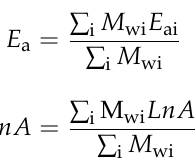
Table 3. Contributions to the activation energy and frequency factor for four chemical groups.